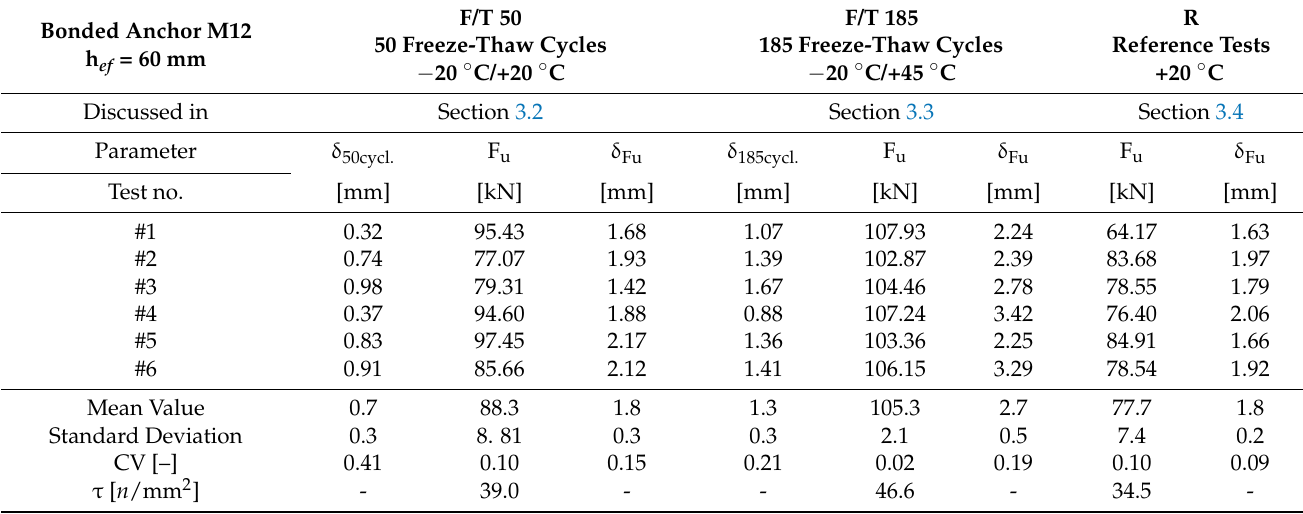
Table 2. Test results of the freeze-thaw tests with 50 cycles, 185 cycles and the reference